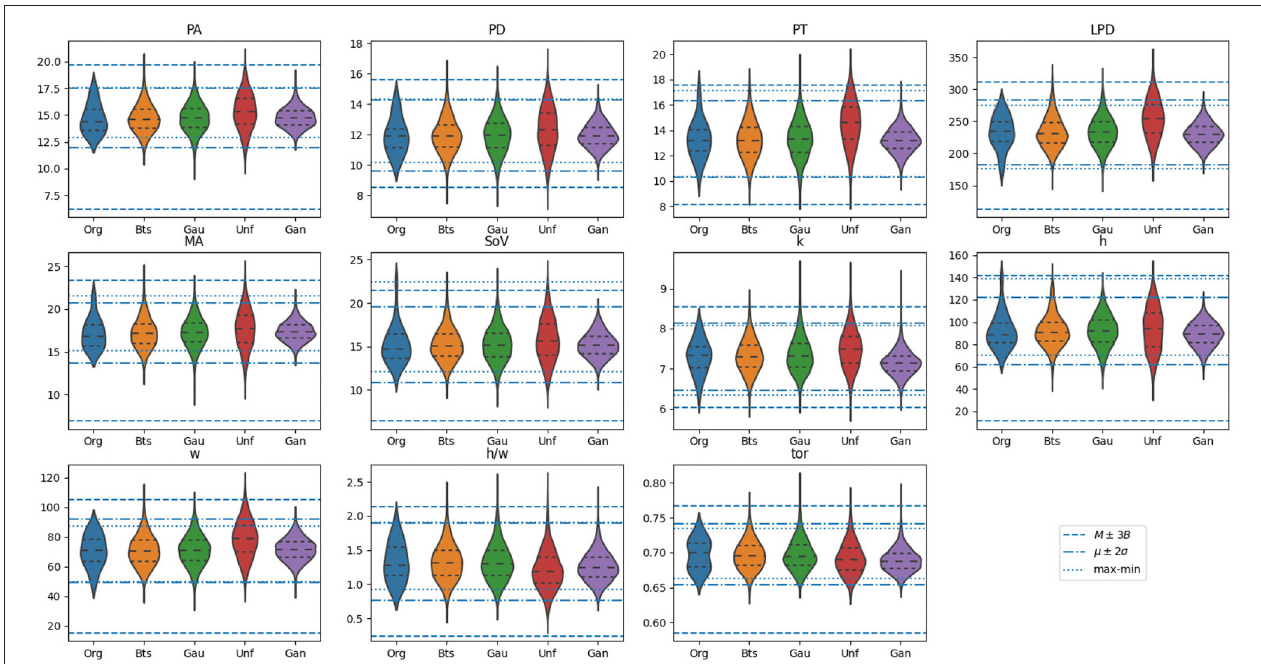
FIGURE 5 | Violin plots for the distribution of biomarkers on the original samples, alongside with those generated using the proposed methods: Bootstrap (Bts), Gaussian (Gau), Uniform (Unf) and generative adversarial network (GAN). Horizontal lines mark the bounds for the different acceptance criteria defined in section 2.5: A r , with dotted lines, A µ , with dash-doted lines, and A M with dashed lines. The units of the vertical axis are in millimeters, except for biomarkers k , which is expressed in mm − 1 , and h / w and tor which are a